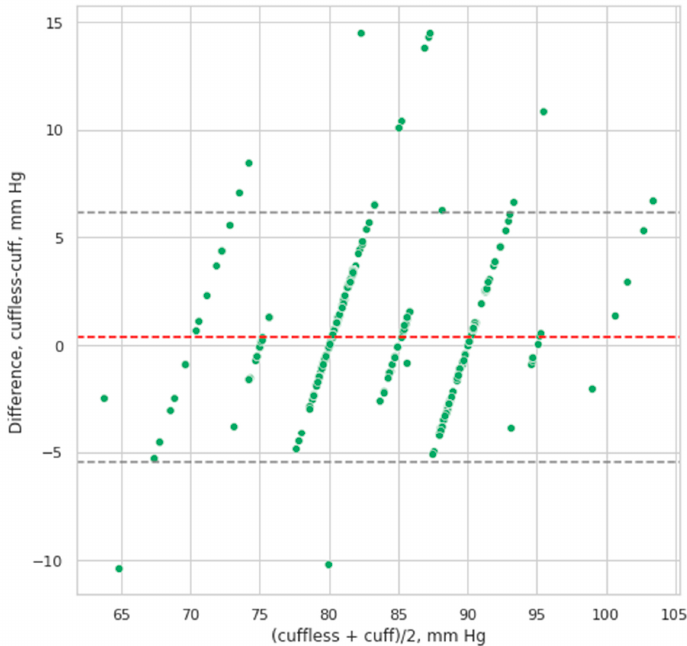
Figure 5. Bland–Altman plot of diastolic blood pressure values derived from cuff based versus cuffless measurements. At different pressure levels in patients, there were no statistically significant differences between the two methods. On average, the pressure varied by 2–4 mm Hg. (Figure 6).